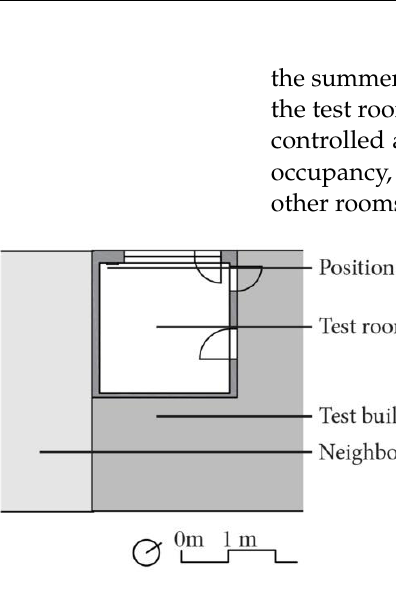
Figure 3. Left : Ground plan of the test room. Right : Exterior wall of the testing room.